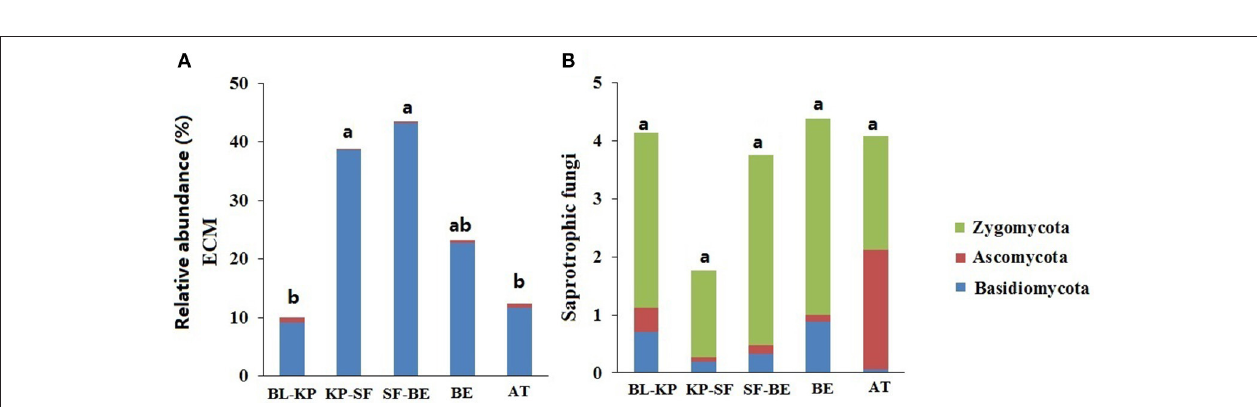
FIGURE 6 | The elevational distribution patterns of the mean relative abundance of two fungal functional groups: ECM (A) and saprotrophic fungi (B) , and their phylogenetic affiliation. Significantly different ( t -test, P adjust < 0.05) groups are denoted with different letters.